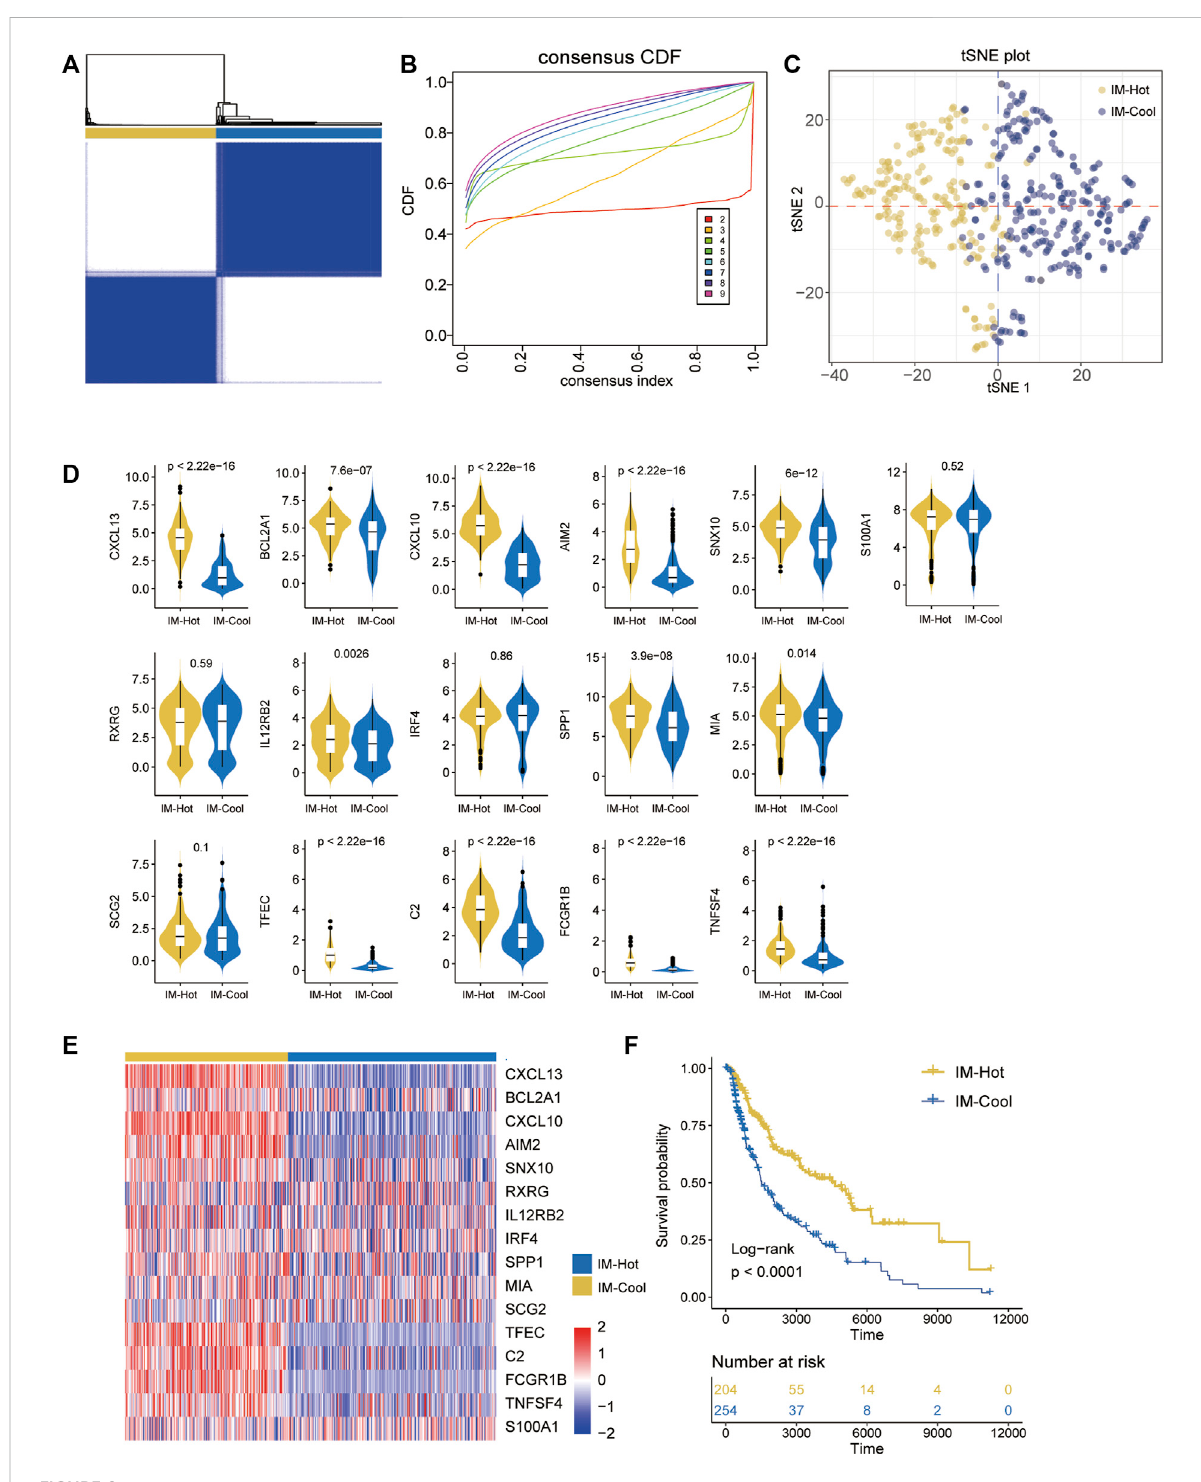
FIGURE 2 Identi fi cation of immune-related SKCM subtypes in the TCGA cohort. (A) The heatmap depicts the consensus matrix at k = 2 in the TCGA group. (B) Thecumulativedistributionfunction(CDF)curves inconsensus clusteranalysis.Consensus scoresfordifferentsubtypenumbers(k=2 – 9) are presented. (C) The strati fi cation into three subtypes validated by t-SNE in TCGA cohorts. Each dot represents a single sample, and each color denotesasubtype. (D) Box fi gure:the16overlappedpartrepresentsthecommonDEGsinthetwoTCGAcohorts. (E) heatmap:the16overlapped part represents the common DEGs in the two TCGA cohorts. (F) Survival analysis of patients with the three diffuse glioma subtypes (IM-Hot and IM- Cool) in TCGA cohorts. The log-rank test was conducted to determine the signi fi cance of the